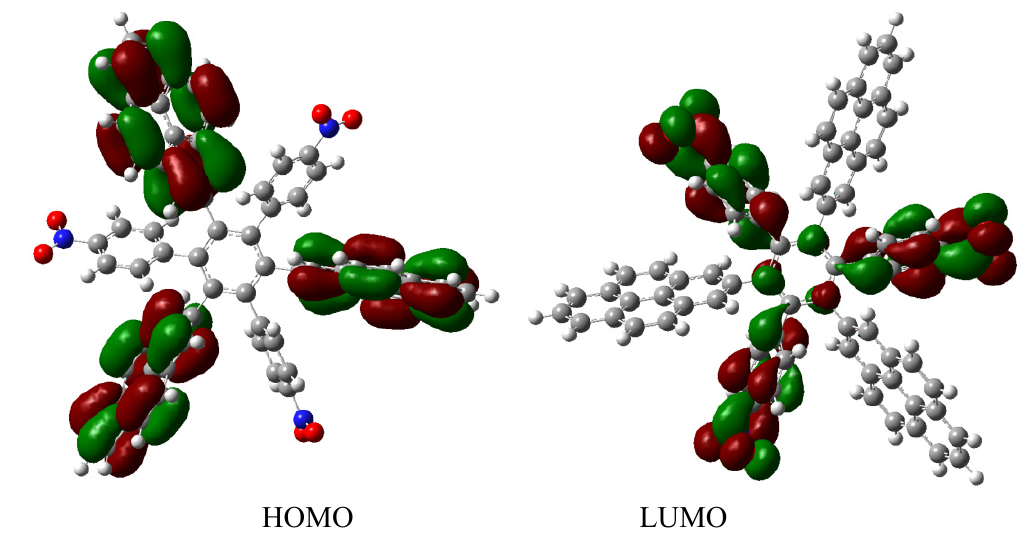
Figure 17. Frontier molecular orbitals for HAB8